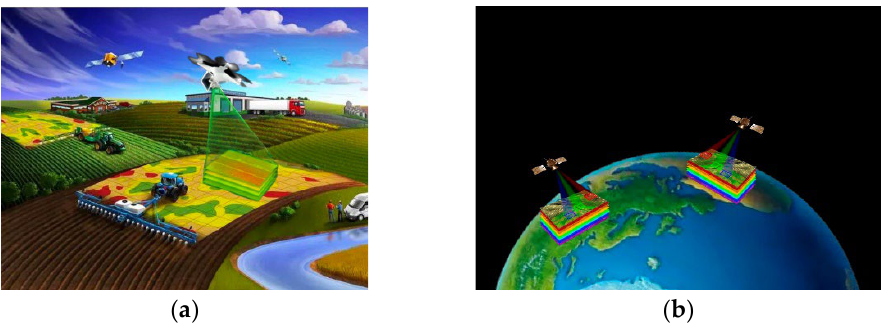
Figure 1. Application of hyperspectral images. ( a ) Hyperspectral imagery for agricultural applica- tions. ( b ) Hyperspectral images for Earth observation.